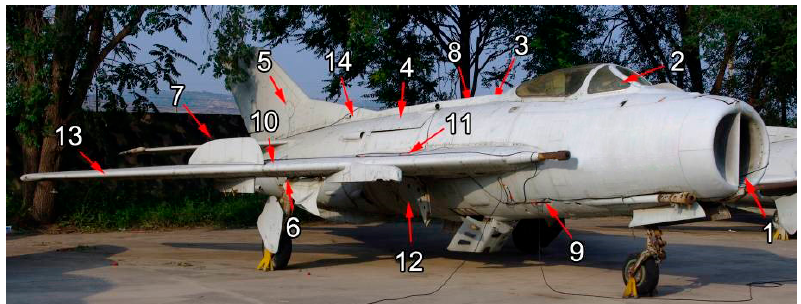
Figure 1. Measurement of local temperature and humidity inside aircraft. 1: Inlet; 2: Cockpit; 3: Front tank; 4: Engine inspect bay; 5: Tail bottom; 6: Landing gear bay; 7: Exhaust nozzle; 8: Main tank; 9: Gun well; 10: Wing middle part; 11: Wing root; 12: Fuselage bottom; 13: Wingtip; 14: Fuselage posterior; 15: Thermometer shelter.